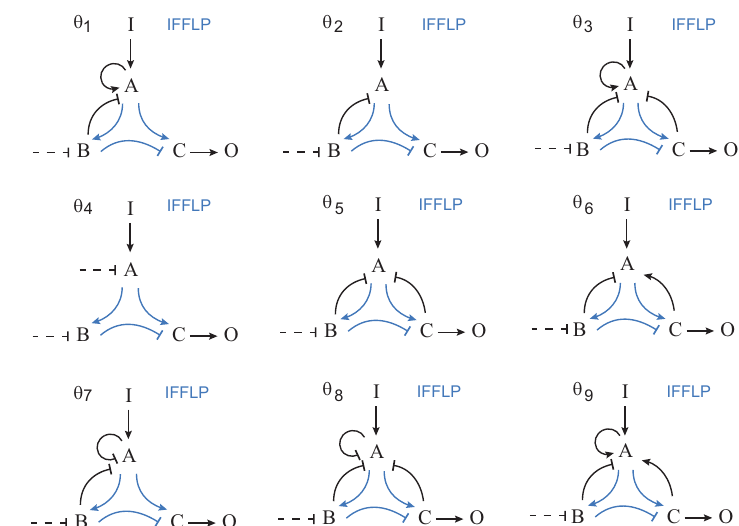
Figure 4. Topologies of the first nine most frequent structures.